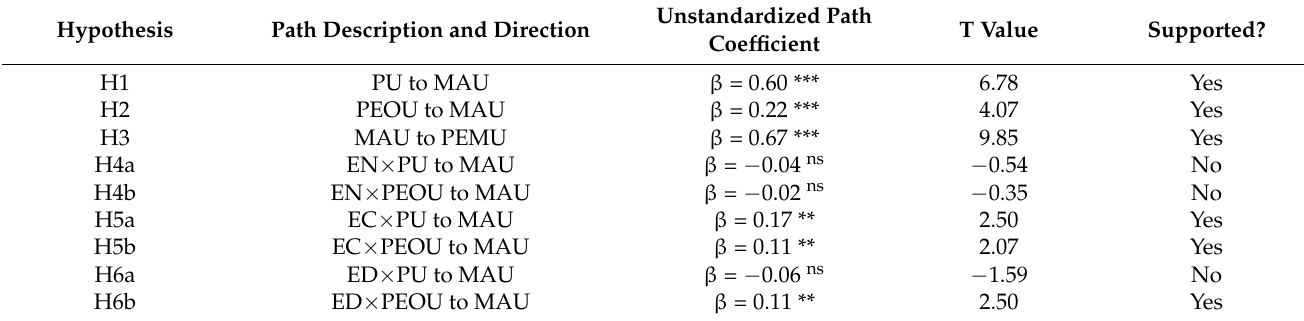
Table 4. Results of the Hypothesis Testing.